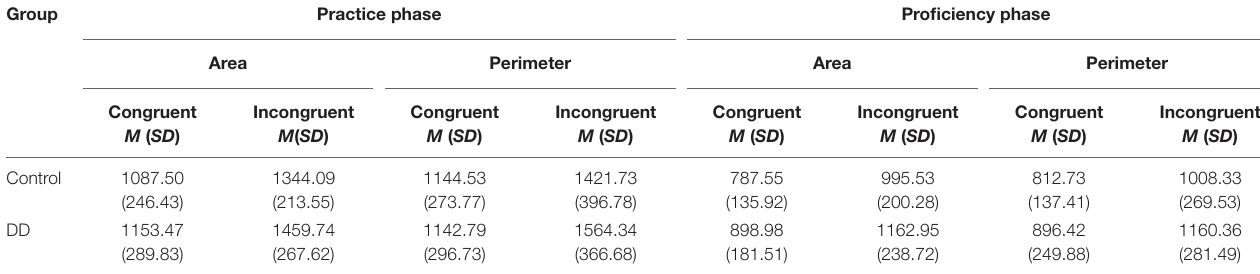
TABLE 4 | Mean reaction times (in ms) in area and perimeter tasks across different exposure phases of the two groups. Group Practice